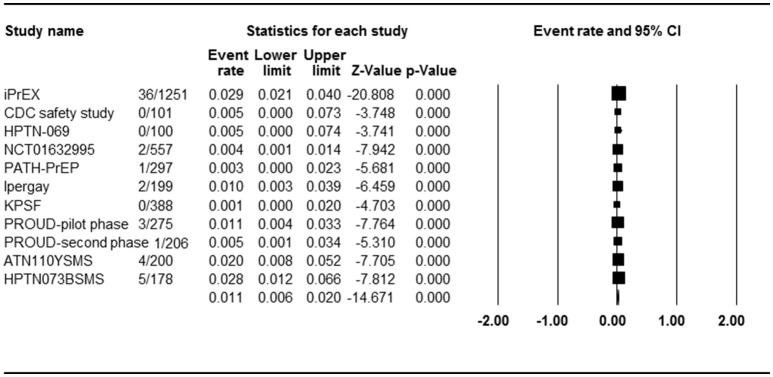
Forest plot for overall analysis of PrEP and HIV incidence (ER).